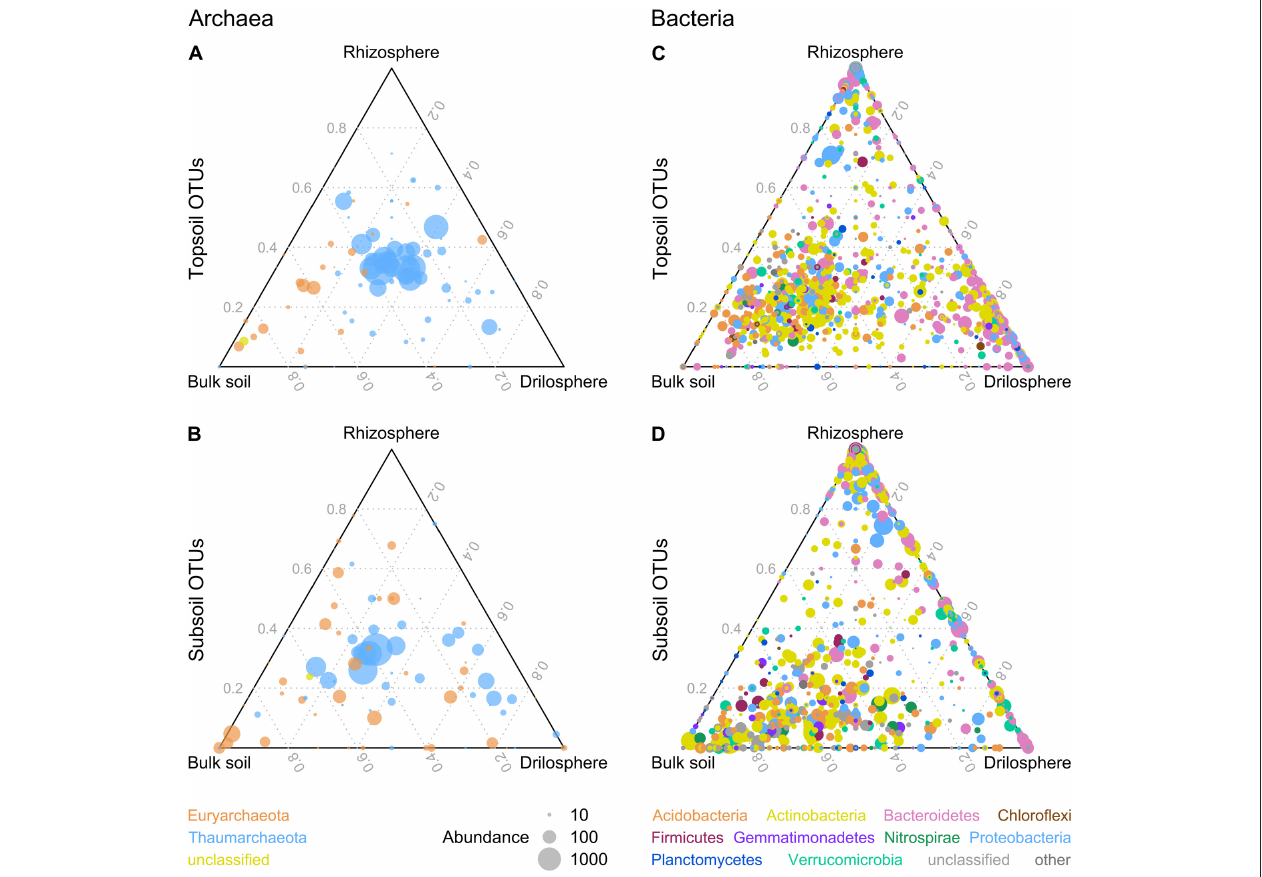
FIGURE 3 | Distribution of archaeal (A,B) and bacterial (C,D) OTUs between soil compartments in ternary plots. OTUs with a higher abundance in topsoil or subsoil are displayed in (A,C) or (B,D) . Similarity level is 95% and only OTUs with a minimum absolute abundance of 5 are shown. The size of the dots represents the absolute abundance of one